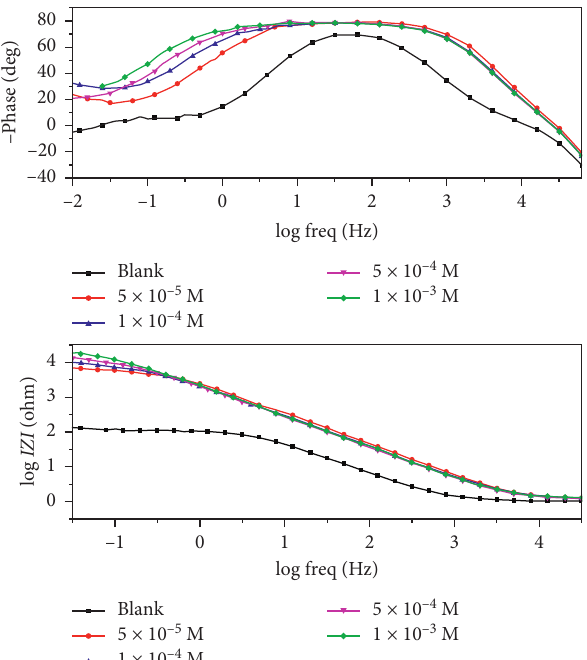
2 SO 4 in the absence and